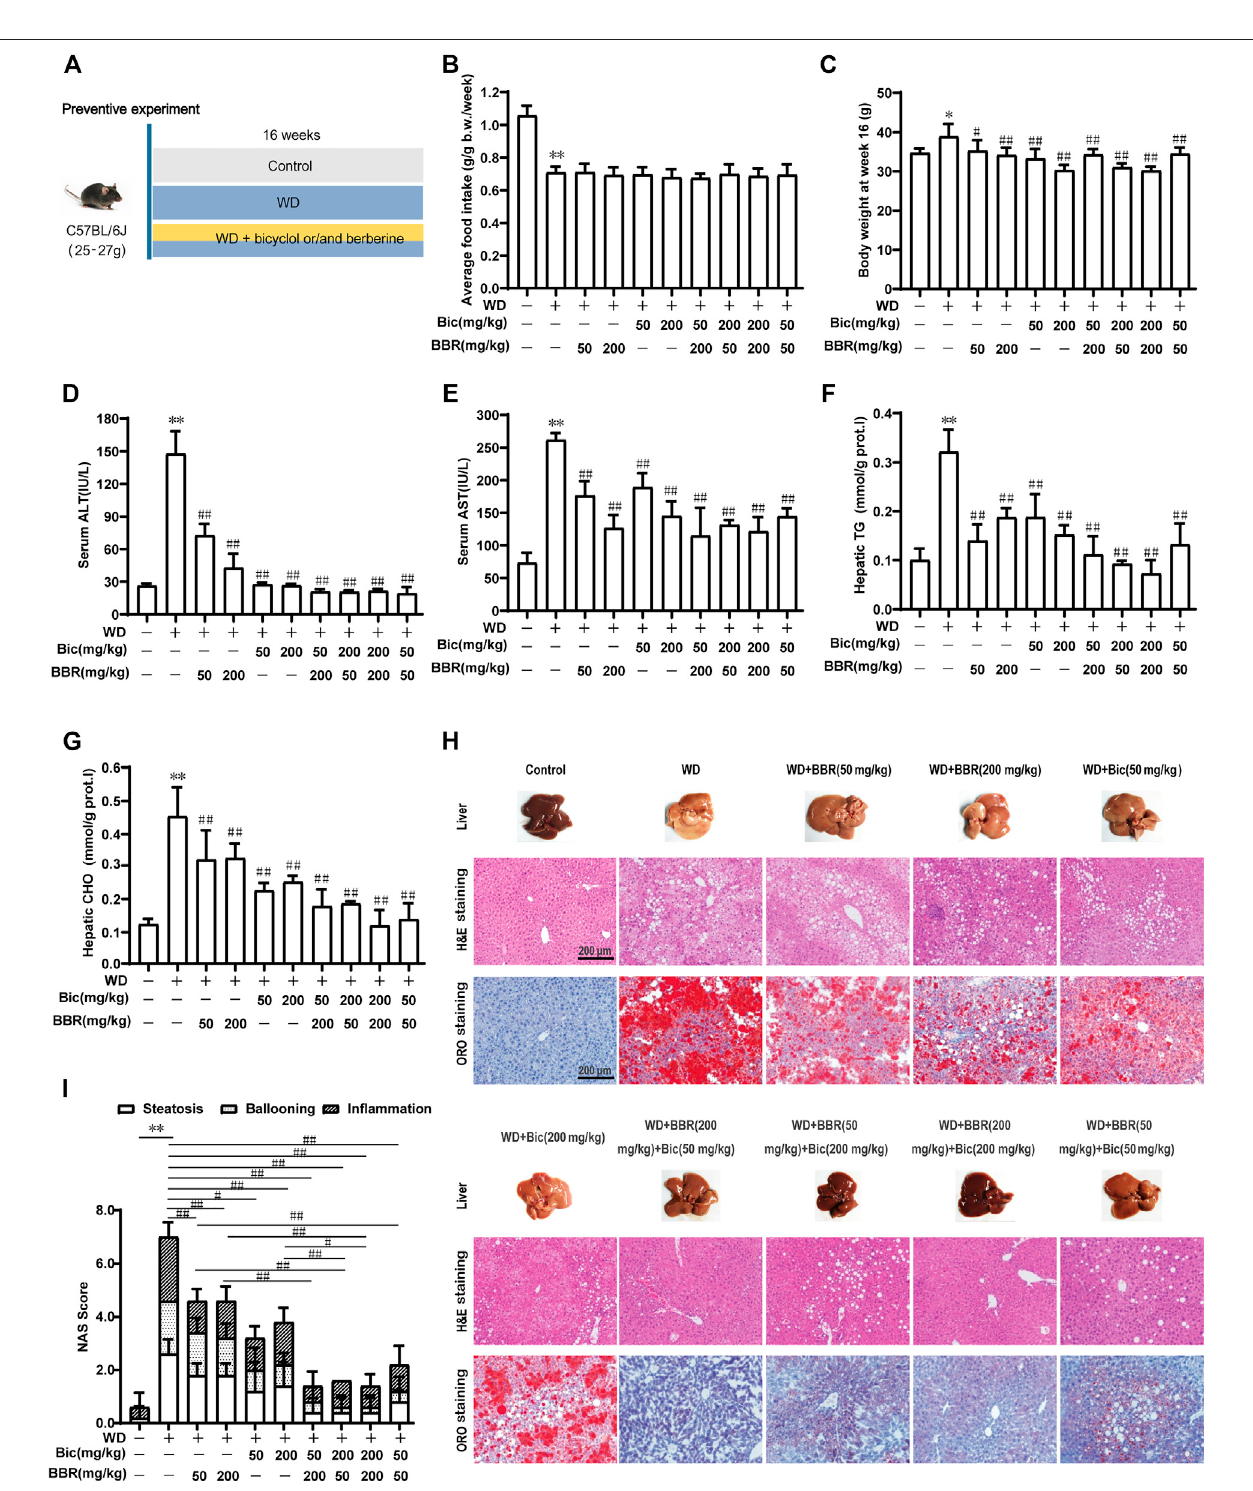
FIGURE 1 | Combination of bicyclol (Bic) and berberine (BBR) exerts better preventive effects in mice with NAFL induced by Western diet. Male C57BL/6J mice weretreatedbyfreefeedingwithWesterndiet(WD)orWDmingledwithbicyclolor/andberberine (A) .Theaveragefoodintakeduringthewholeexperiment (B) andbody weightatweek16 (C) wererecorded.Atweek16,ALT (D) andAST (E) inserumweredetected,andTG (F) andCHO (G) intheliverweremeasured.Liverhistopathology was evaluated using H&E and ORO staining (H) and quanti fi ed with NAS score criteria (I) . Results were presented as mean ± SD. n = 5 for each group, *p < 0.05 and **p < 0.01, WD-induced model group vs. the control group; # p < 0.05 and ## p < 0.01 vs. the WD-induced model group or monotherapy group.